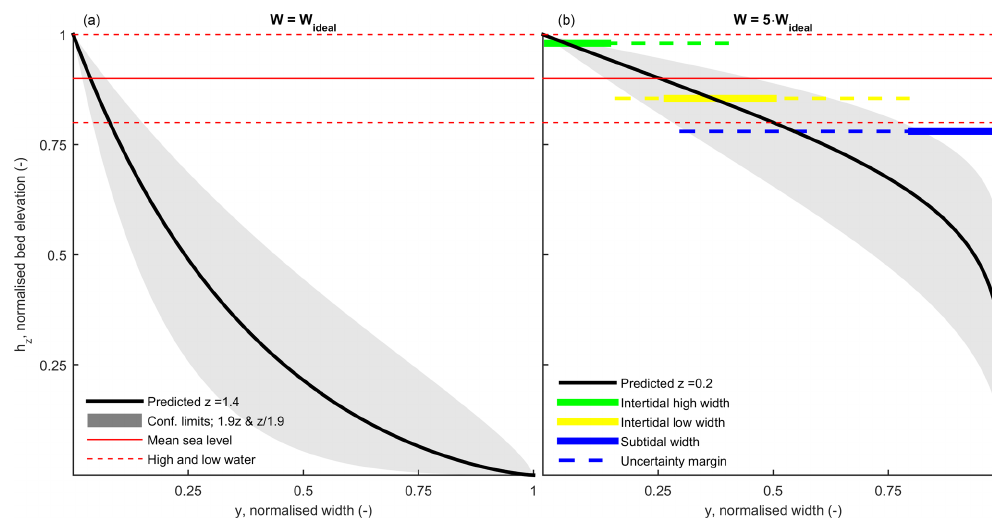
Figure 9. Illustration of uncertainty in the predicted hypsometry from Eq. (6) with uncertainty margins (Fig. 8). Resulting prediction for hypothetical location where (a) local width is equal to the ideal width and (b) local width is 5 times larger than the ideal width. Results are compared against a typical tidal range in order to show the uncertainty of predicted intertidal high width, intertidal low width and subtidal width as a fraction of the total estuary width.